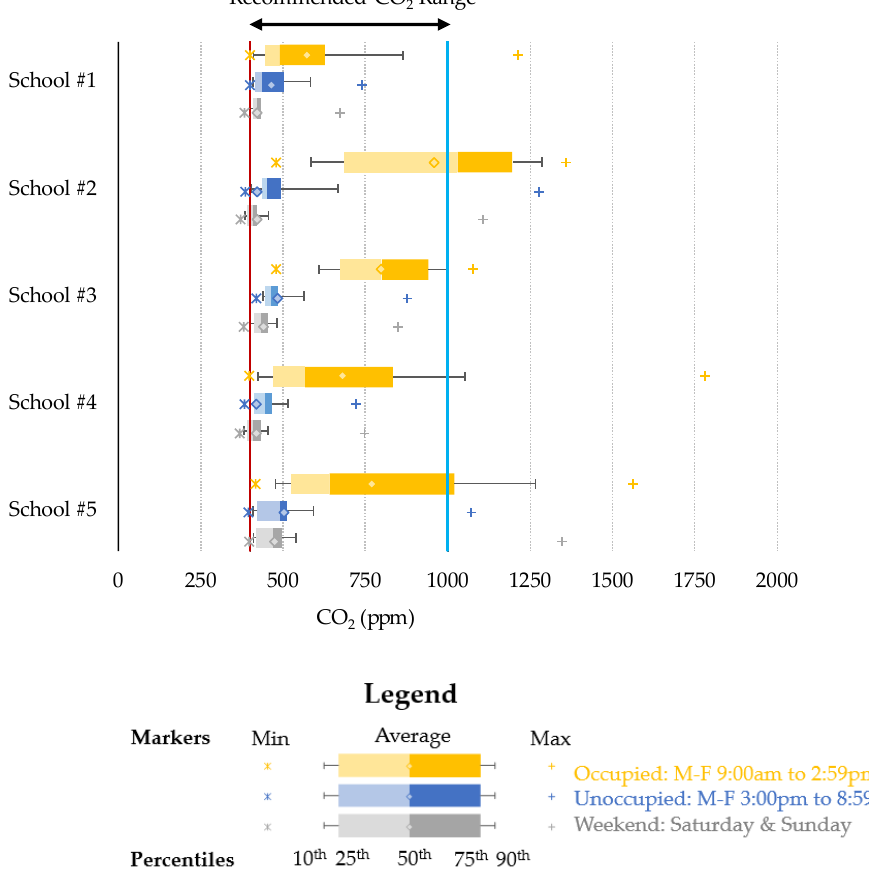
Figure 7. Classroom CO 2 Statistical Distributions by Occupancy Mode.